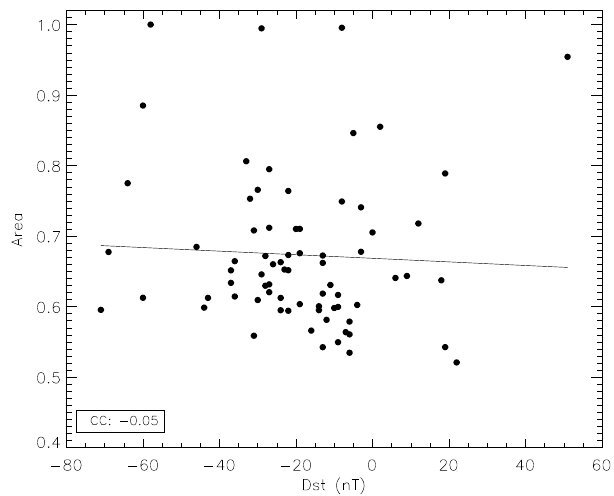
Figure 14. The relationship between the area of CRW and the AE index during different time of geomagnetic storm on 13 Novem- ber 1998. The y axis has been normalized.